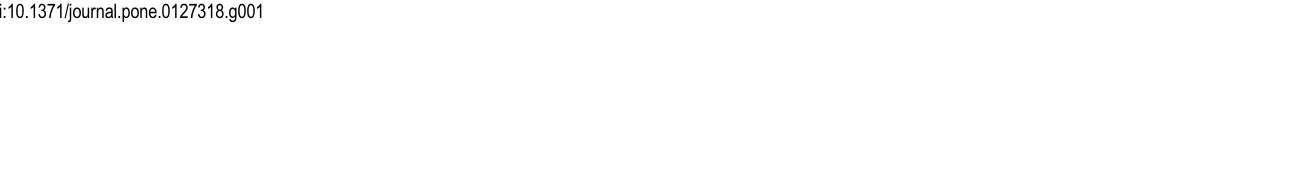
PLOS ONE | DOI:10.1371/journal.pone.0127318 May 18,